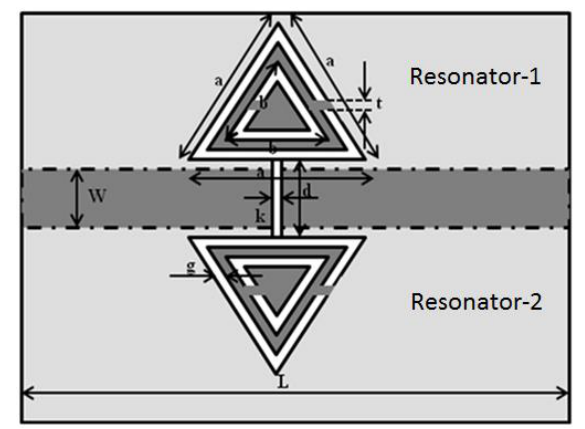
Fig. 6: Proposed design of dual-band microstrip bandstop filter with triangular CSRR-DGS This dual-band microstrip bandstop filter is designed at two resonant frequencies which are 3.5 GHz and 5.7 GHz respectively. In this proposed design the same dielectric material is used with the same specification with the above designed filters using the same 50Ω microstrip line. The dimensions of this proposed dual band bandstop filter are given as: resonator-1 (a = 3.5 mm, b = 2.8 mm, g = 0.35 mm, t = 0.3 mm, d = 12 mm and k = 0.3 mm) and resonator-2 (a = 3.3 mm, b = 2.6 mm, t = 0.3 mm, k = 0.3 mm)